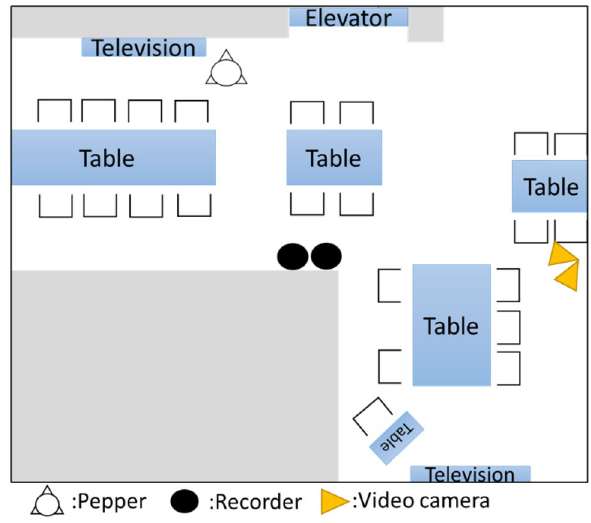
Fig. 2 Experimental setup of the living